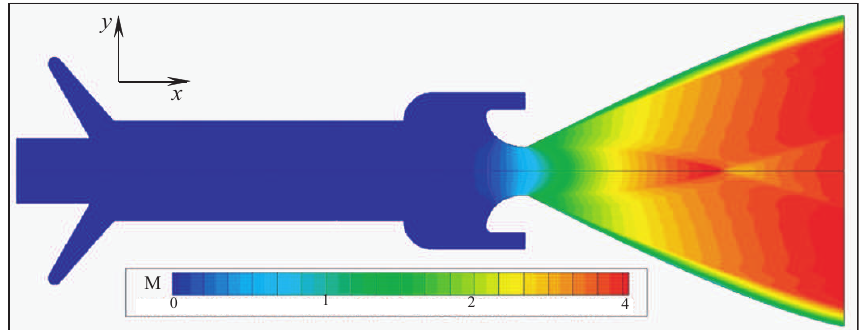
Figure 10. Contours of the Mach number in the channel and